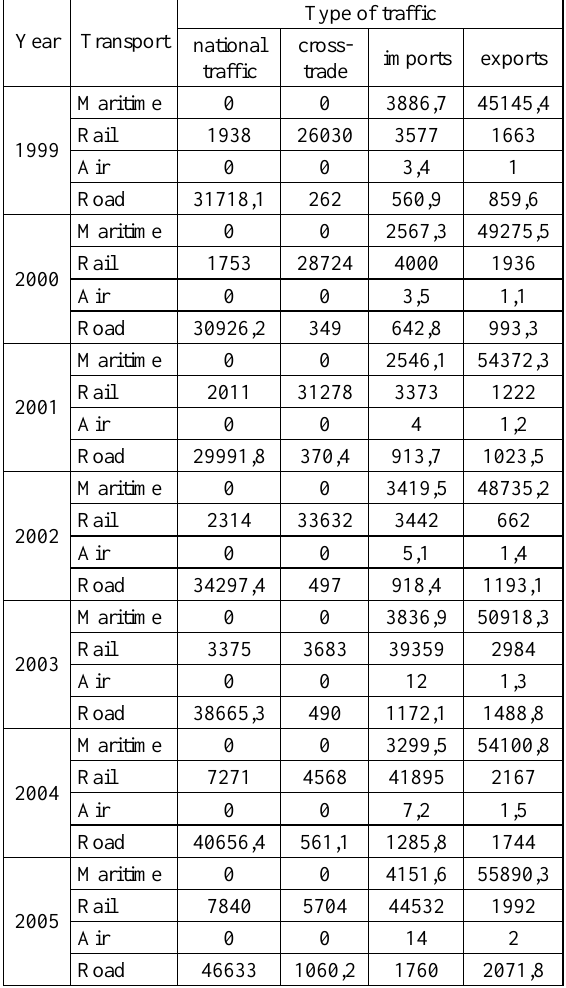
Fig 4. Components of the cargo flow by modes of transport in Latvia from 1999 to 2005 Table 1. Statistical data about transportation of cargoes by types of communications and modes of transport in Latvia from 1999 to 2005 Type of